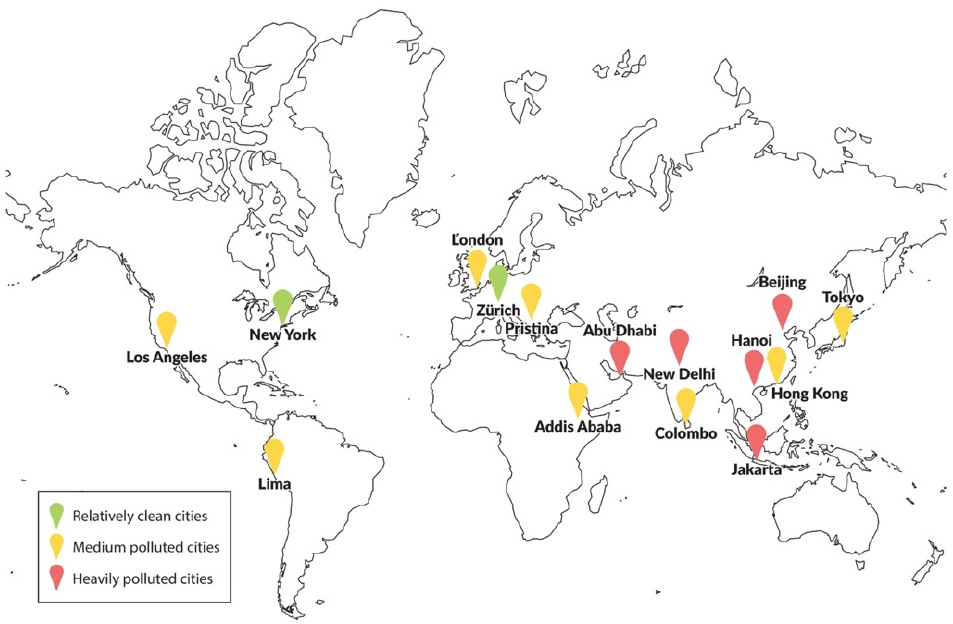
Figure 1. Selected cities for this air quality study.